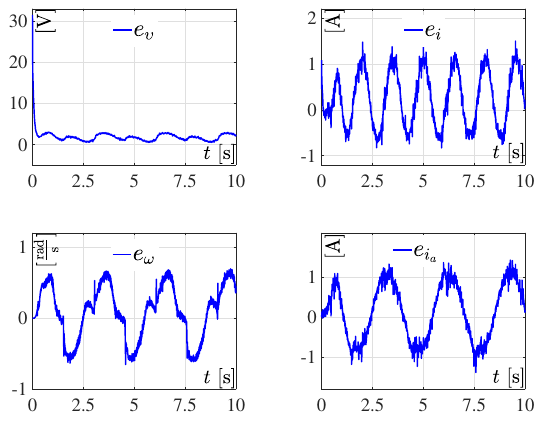
Figure 14. Tracking errors related to experiment 4.